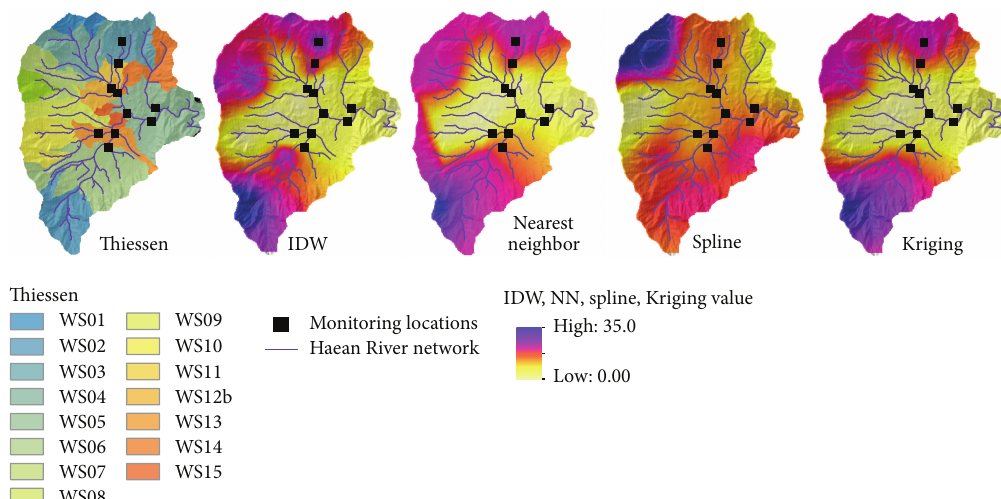
Figure 3: Example spatial distribution of interpolation schemes for the Haean catchment using the Thiessen, inverse distance weighted (IDW), nearest neighbor, spline, and ordinary Kriging methods. The sample time was August 10, 2010, at 20:00, when the highest range in precipitation was